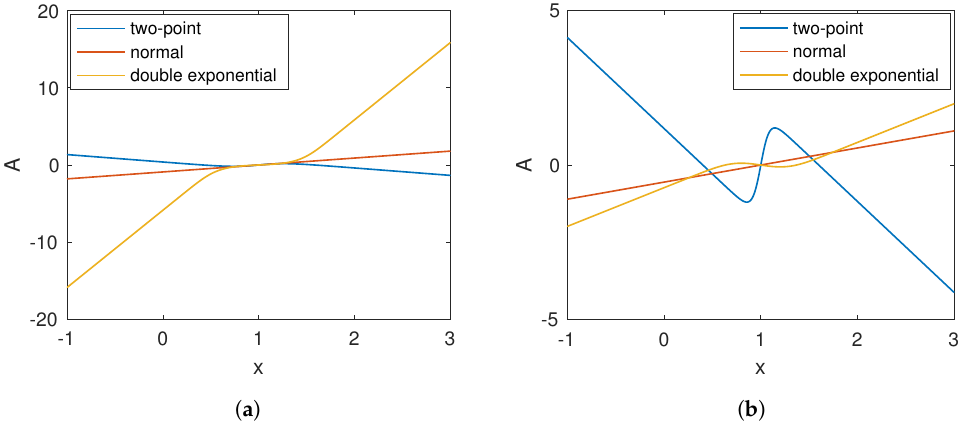
Figure 2. A ( t , x ) under three different distribution with common M EAN = 0 and V AR = 0.36 at t = 0.1 ( a ) and t = 0.8 ( b ). Parameters: (two-point) δ u = − δ d = 0.6, p u = p d = 0.5; (normal) µ = 0, σ D = 0.6; (double exponential) θ = 0, p 1 = p 2 = 0.5, λ 1 = λ 2 = 2.357. Common parameters: S 0 = 2.72 ( X 0 = 1 ) , r = 0.1, ¯ T = 1, T = 1.1, σ =